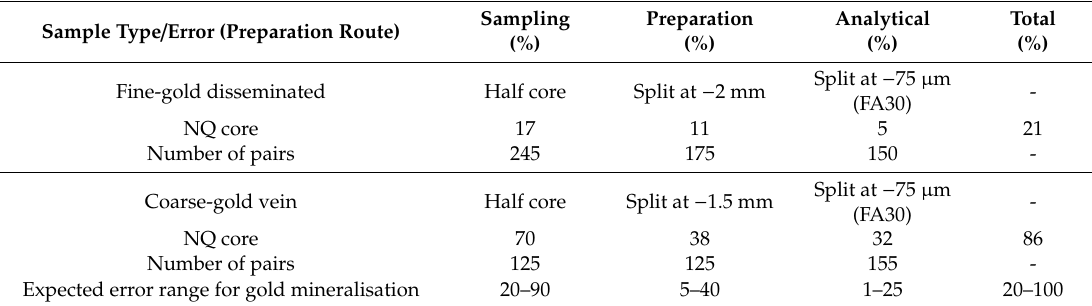
Table 2. Examples of duplicate pair analysis from contrasting styles of gold